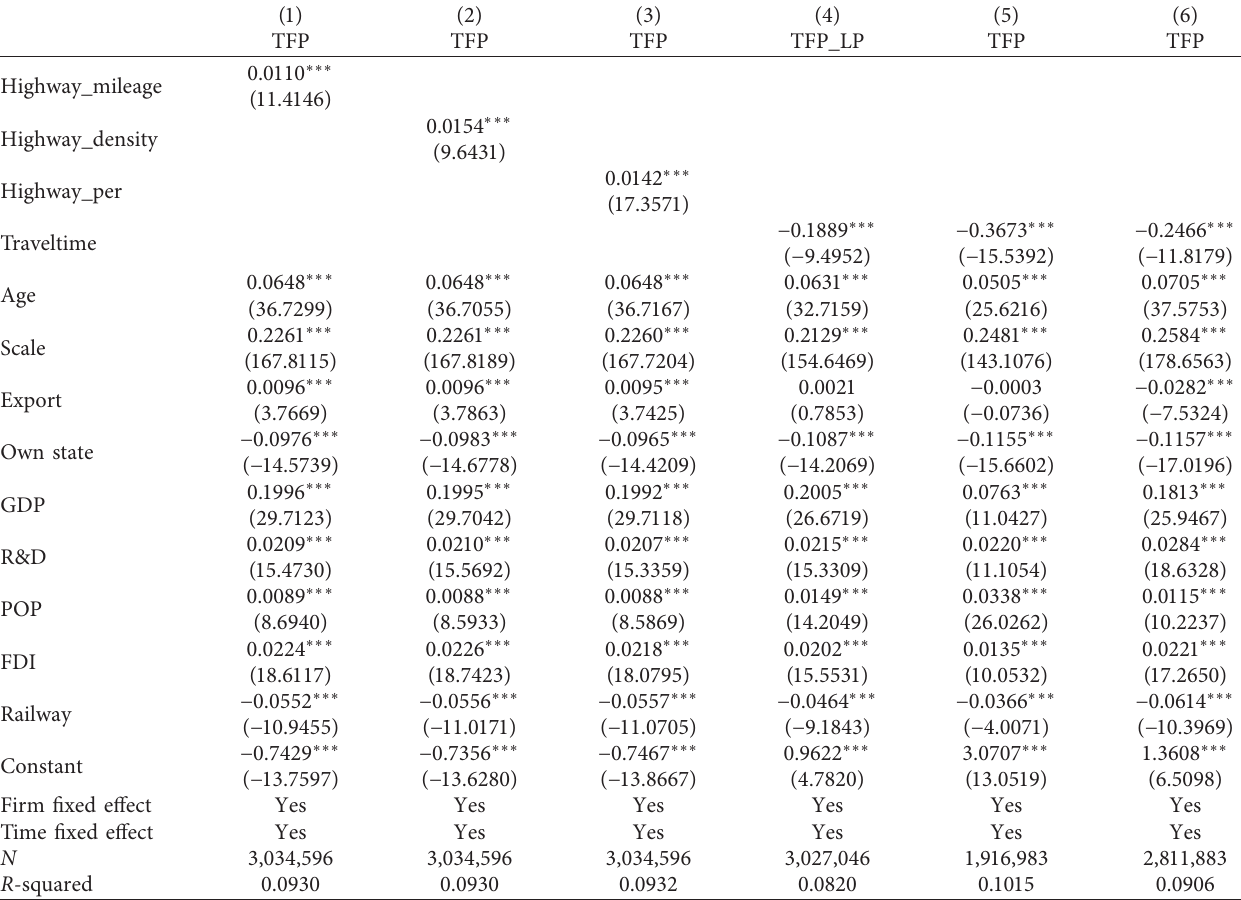
Table 8: Result of robustness